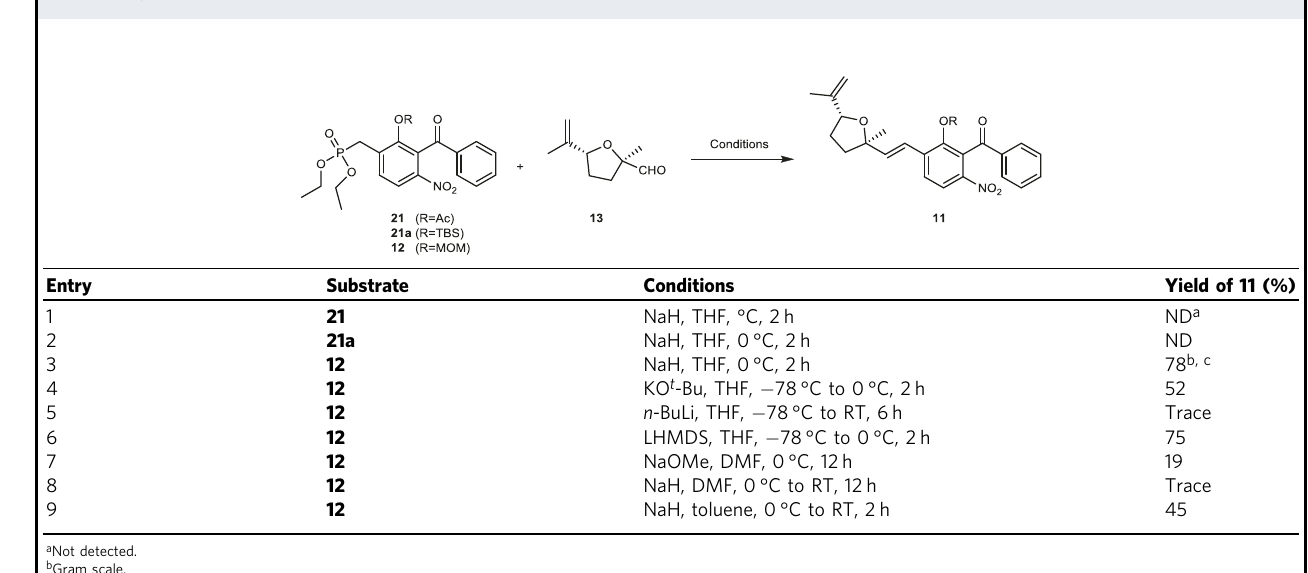
Table 1 Optimization of reaction